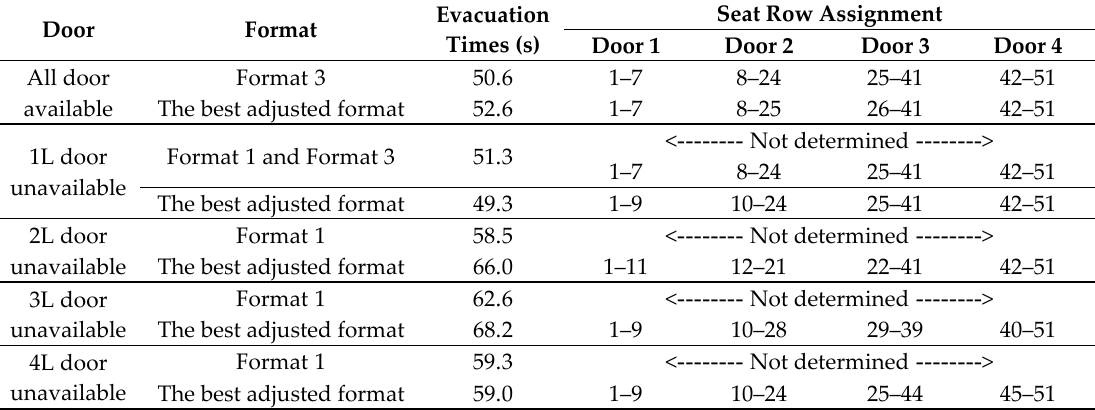
Table 6. Comparison of best adjusted formats and the best previous